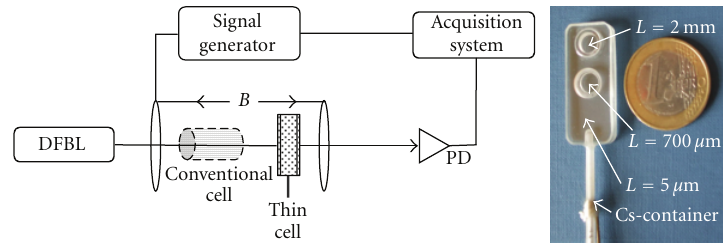
Figure 2: Principal scheme of the experimental setup (left) (DFBL: distributed feedback laser, PD: photodiode, B : magnetic field directions) and photo of the optical cell used in the experiment